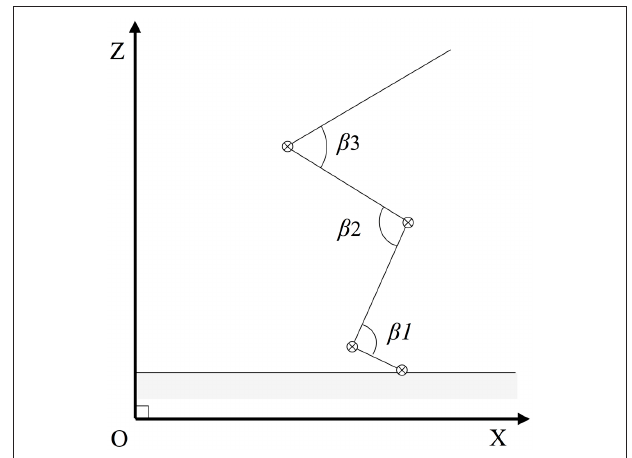
FIGURE 3 | Articular angles of the jumper. The model of the jump (see Figure 2 ) includes three rotation axis ( ⊗ ) corresponding to three articulations (hip, knee, and ankle joints) thus to three articular angles β